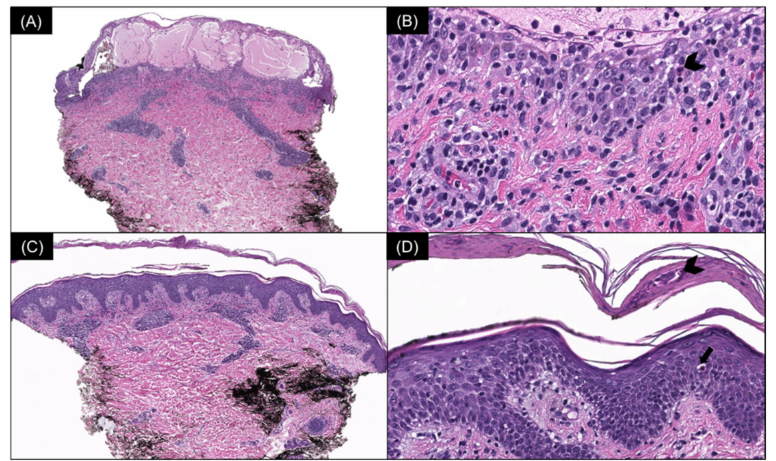
Figure 2. ( A ) Acute lesion: spongiotic vesiculation and reticular degeneration of the epidermis (H & E, 40 × ) with ( B ) intraepidermal necrotic keratinocytes (arrowhead) (H & E, 400 × ). ( C ) Chronic lesion: mild epidermal hyperplasia and a moderately dense superficial perivascular lymphocytic infiltrate (H & E, 40 × ) with ( D ) overlying parakeratosis containing neutrophils in the stratum corneum (arrowhead) and intraepidermal necrotic keratinocytes (arrow) (H & E, 200 ×